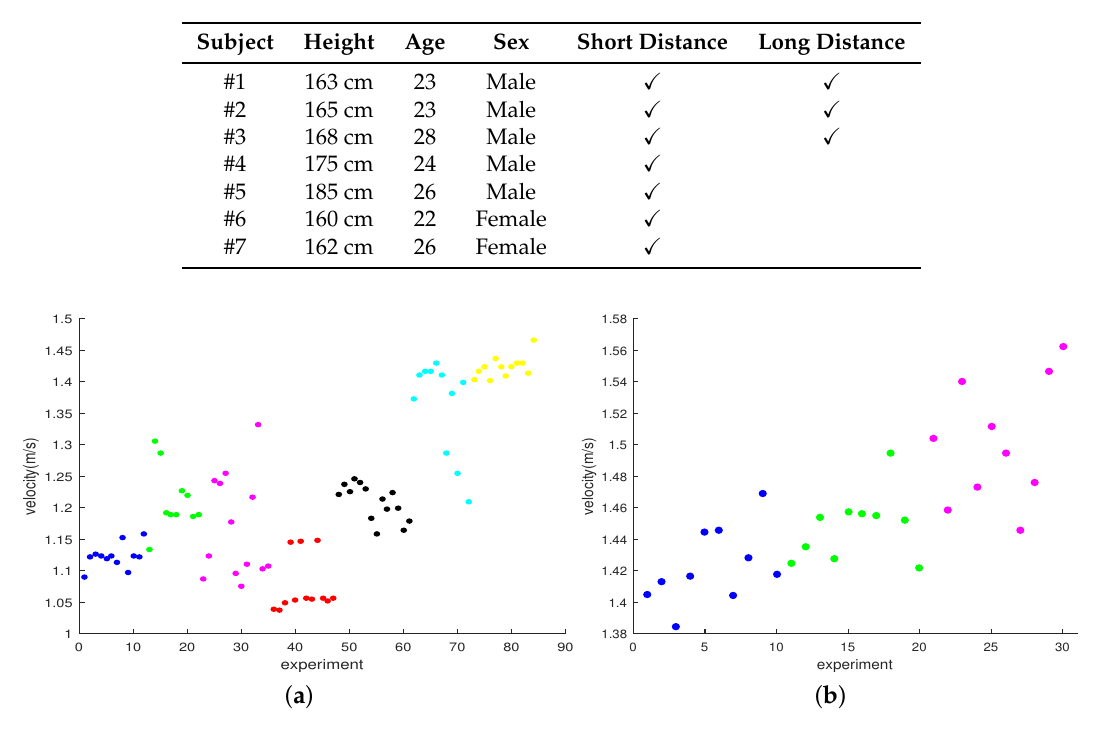
Table 2. Baseline of individuals.